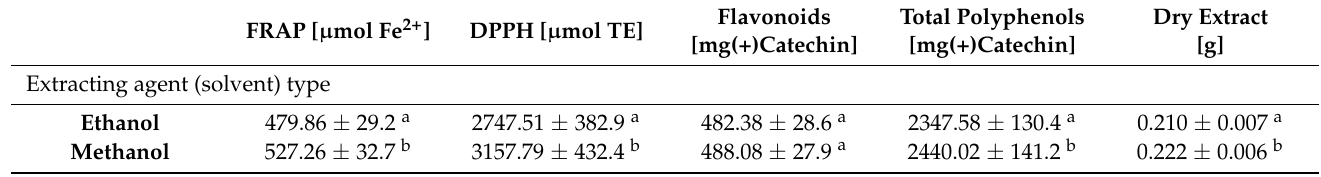
Table 3. The influence of the kind of solvent used on the antioxidant properties of the elderflower extracts (FRAP, DPPH), the total contents of flavonoids and polyphenols, and the contents of the dry extract in grams (SE ± , n = 192).